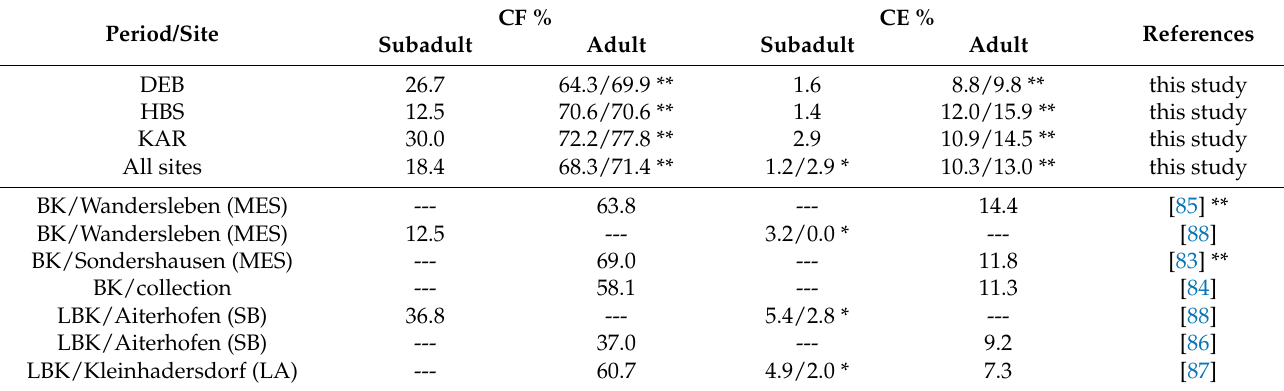
Table 7. Caries frequency (CF) and caries experience (CE) amongst adult and subadult individuals compared to other Neolithic and Early Bronze Age datasets from the MES region,